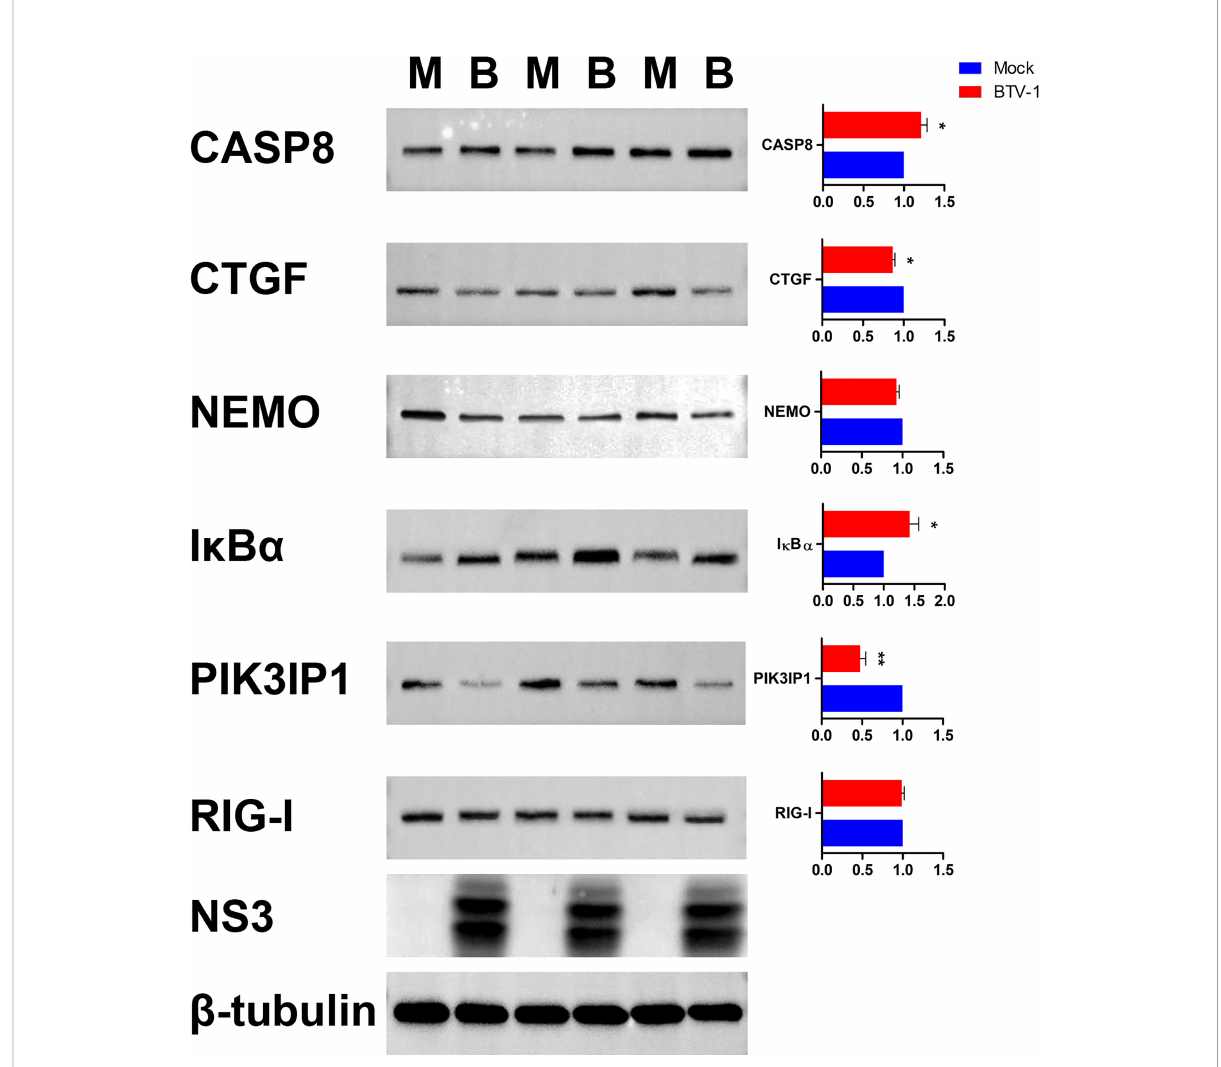
FIGURE 11 Validation the expressions of six dif-mRNAs using WB. The expression patterns of CASP8, CTGF, NEMO, I k B a , PIK3IP1, and RIG-I were validated using WB with speci fi c antibodies. M and B indicated mock-infected and BTV-1-infected groups, respectively. NS3 was detected as control for successful infection, whereas b -tubulin served as an internal control. Symbols * and ** indicated the difference between the indicated groups was signi fi cant ( p -value <0.05) or very signi fi cant ( p -value <0.01),